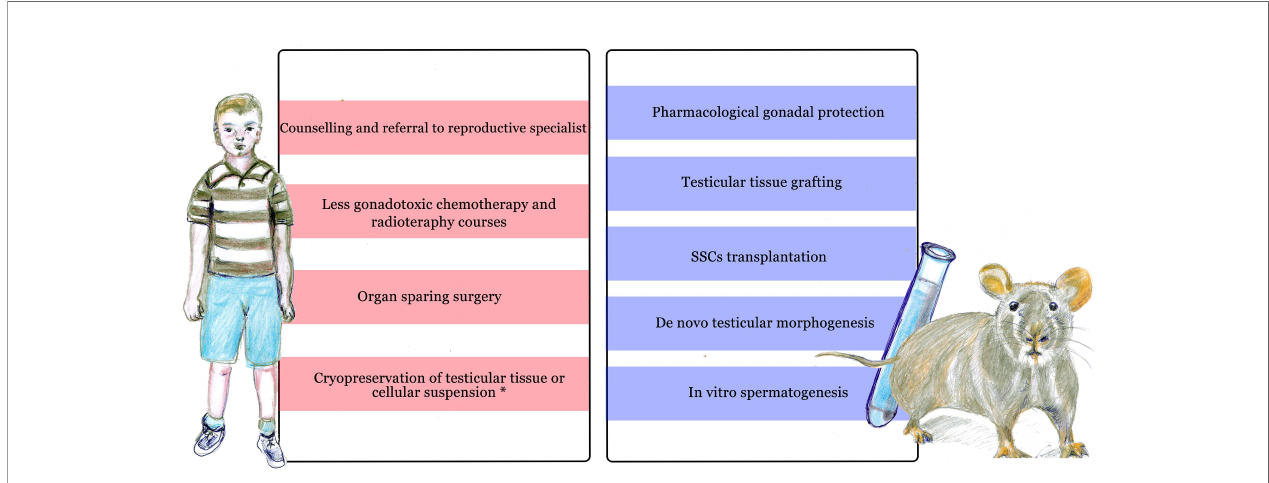
FIGURE 1 | Current approaches to preserve and restore fertility in prepubertal males undergoing cancer treatment. On the left side: current clinical approaches available before and during treatment. On the right side: experimental methods, mainly tested on animal models (including rodents, non human primates and others) or in vitro . *Cryopreservation of testicular material is only available in selected centers during experimental